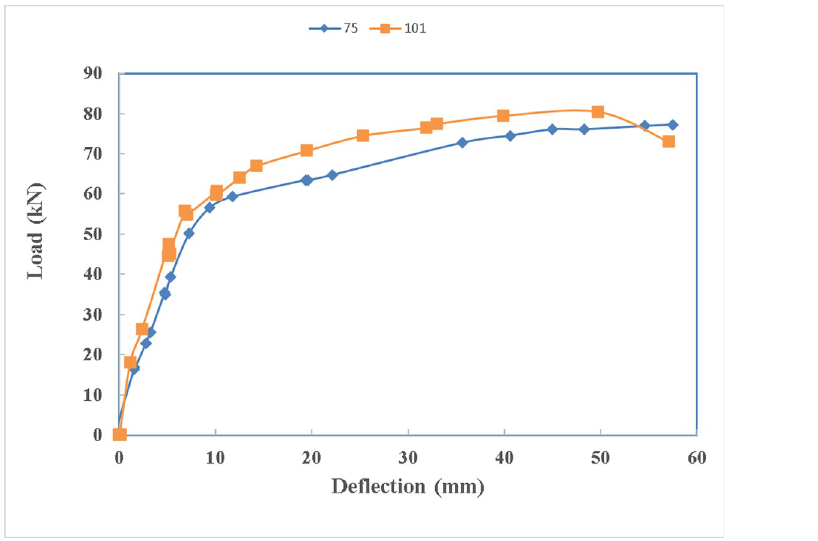
Fig 22. Load- deflection diagram of beams 75 and 101.